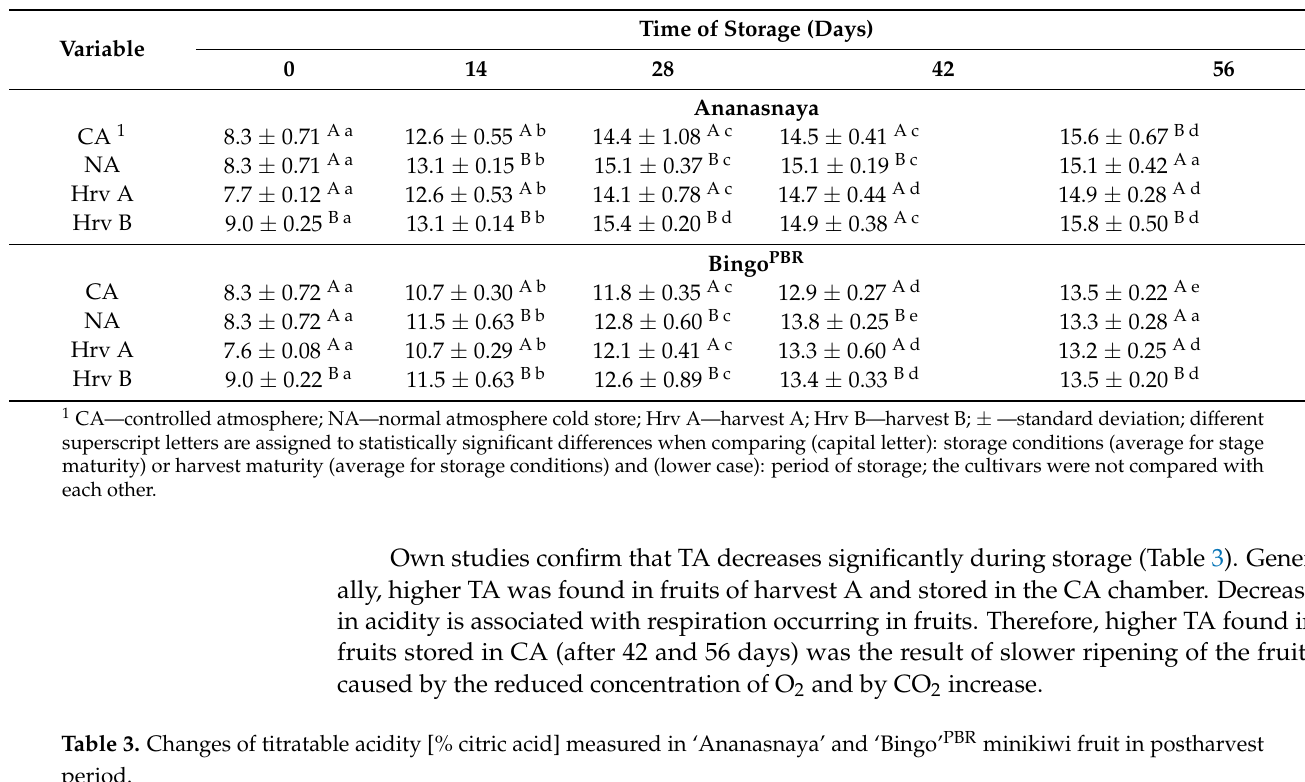
Table 2. Changes of total solids soluble content [ ◦ Brix] measured in ‘Ananasnaya’ and ‘Bingo’ PBR minikiwi fruit in postharvest period.